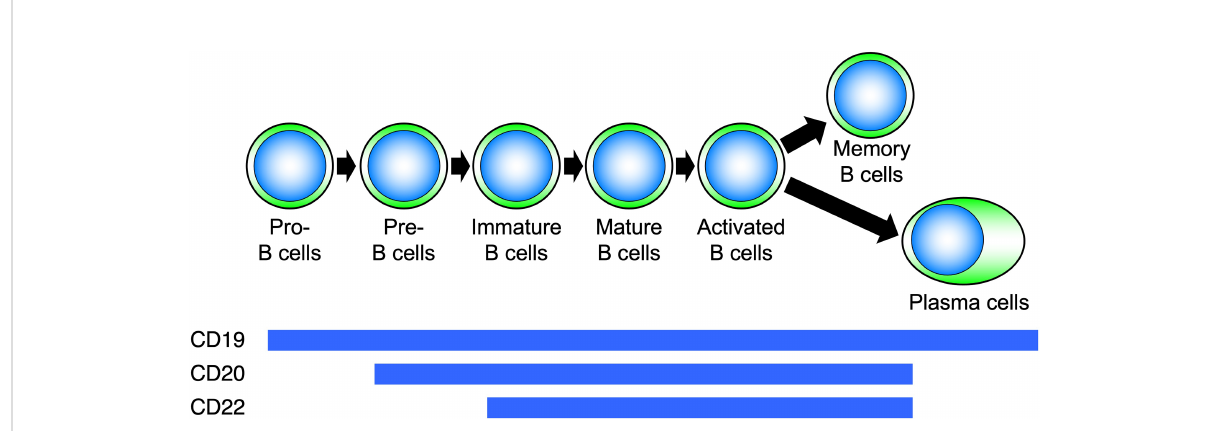
FIGURE 5 Differentiation stages of B cells and expression of surface molecules. Molecules expressed on B cells at each differentiation stage are